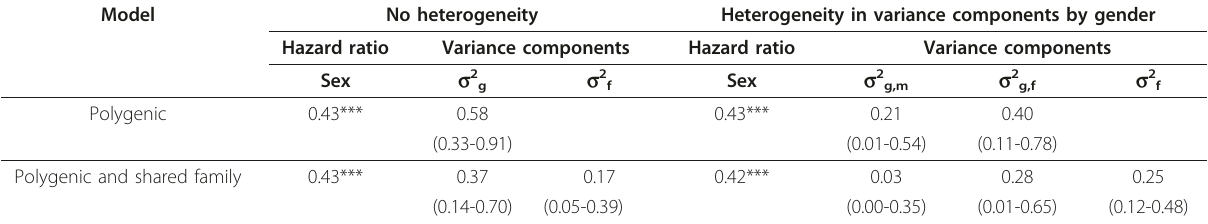
Table 5 Variance-components and hazard ratio estimates for age-at-onset of regular cigarette use in Brazilian families.